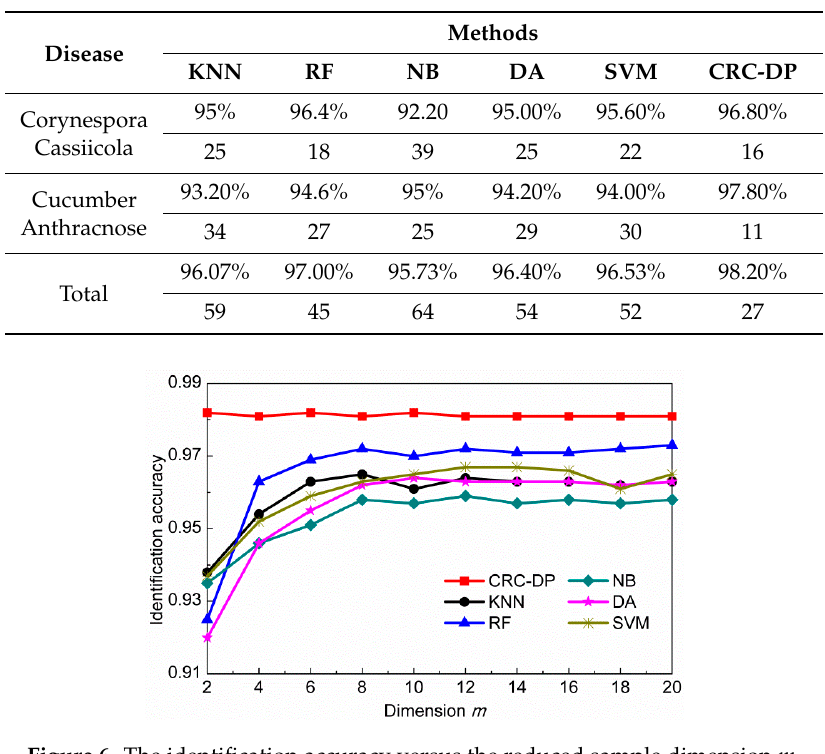
Figure 7. (a) The collaborative representation coefficients of a query sample from the first class; ( b ) the reconstruction residuals corresponding to each disease.